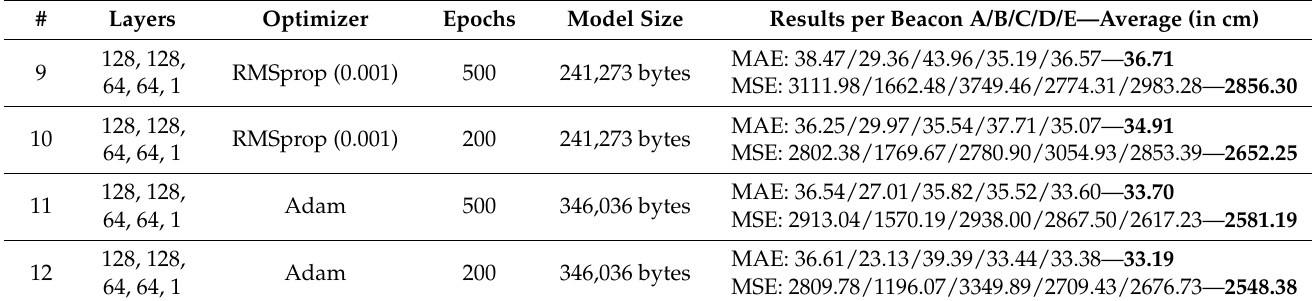
Table 5. Experiments No. 9, No. 10, No. 11, and No. 12 parameters and results.